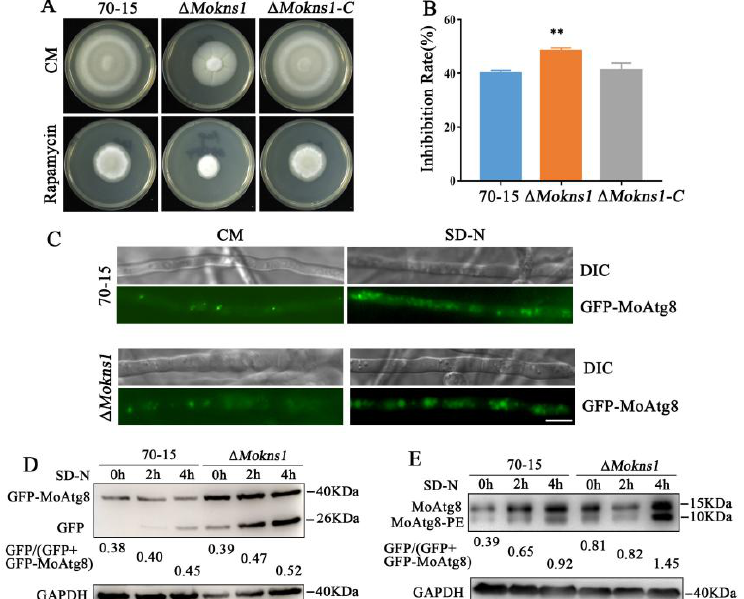
Figure 6. MoKns1 is involved in autophagy. ( A ). Sensitivity test to Rapamycin (Duncan’s test, ** p < 0.01). ( B ). The inhibition rate was determined by comparing the percentage of colonies in the presence of Rapamycin to the percentage of colonies in the control. Asterisks denote statistical significances ( p < 0.01). ( C ). The localization of GFP − MoAtg8 in the 70 − 15 strain and the ∆ Mokns1 mutant. The strains were cultured in liquid CM medium for 2 days, then transferred to SD − N medium for 4 h. Bar, 10 µ m. ( D ). Immunoblot analysis of the degradation of GFP − MoAtg8 in SD − N medium for 2 h and 4 h in the WT strain and ∆ Mokns1 mutant. ( E ). Immunoblot analysis of MoAtg8/MoAtg8 − PE turnover in the wild-type 70 − 15 strain and ∆ Mokns1 mutant.